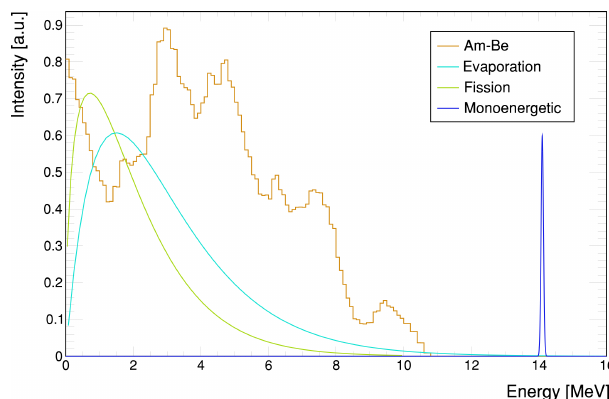
Figure 6. Different preconfigured source distribution functions in URANOS in the MeV range covering different use cases: laboratory test sources like americium–beryllium (yellow), spontaneous fission (green), evaporation (cyan) from nuclear de-excitation and fusion